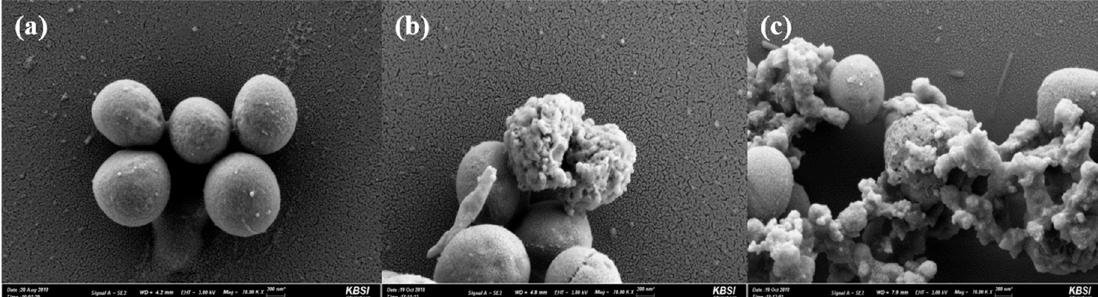
Figure 5. SEM photograph illustrating morphological changes of S. aureus in the absence of YK5 ( a ), and in the presence of 20 μ M ( b ) and 200 μ M of YK5 ( c ).